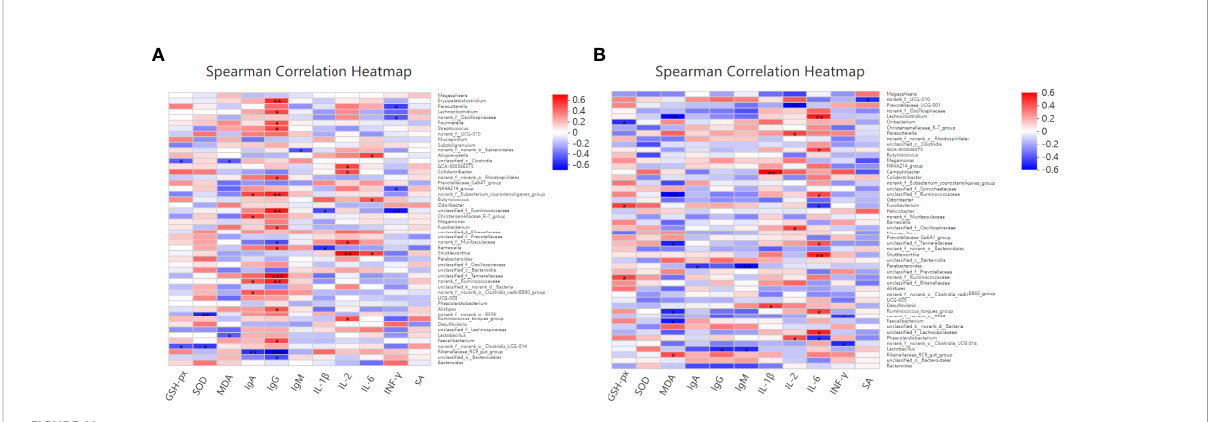
FIGURE 11 Effects of dietary supplementation with different Se sources on the difference of the gut microbiota and its correlation with the antioxidant and immunity of laying hens at 14 days after the challenge with physiological saline solution (A) or S. Enteritidis (B) . Asterisks indicate signi fi cant correlations: * p ≤ 0.05, ** p ≤ 0.01, *** p ≤ 0.001. Blue represents a signi fi cantly positive correlation ( p ≤ 0.05), red represents a signi fi cantly negative correlation ( p ≤ 0.05), and white represents no signi fi cant correlation ( p > 0.05). SA, Salmonella -speci fi c